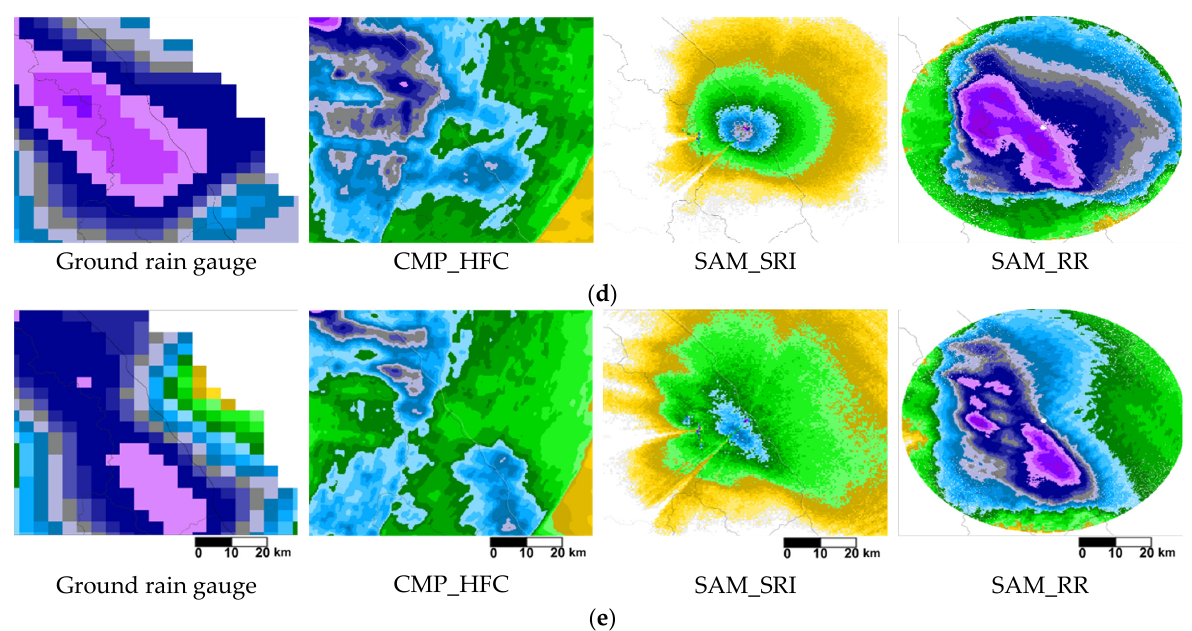
Figure 4. Distribution of accumulated rainfall over 1 h period distribution for maximum rainfall in